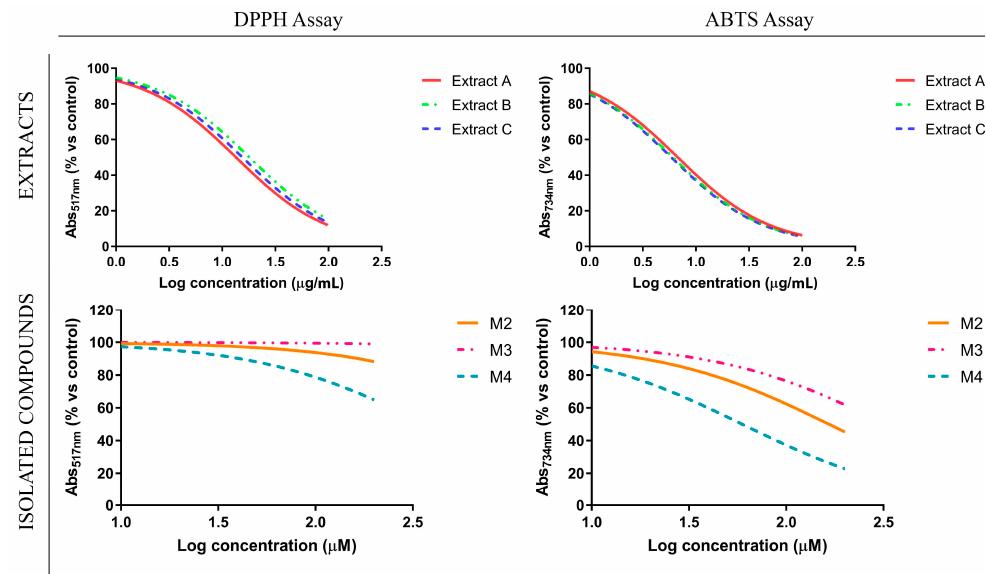
Figure 3. Antioxidant profile of G. glabra L. leaf extracts and isolated flavanones. Table 2. Antioxidant activity (IC 50 values) of G. glabra L. leaf extracts and isolated flavanones. IC 50 ± SD ( µ g / mL)